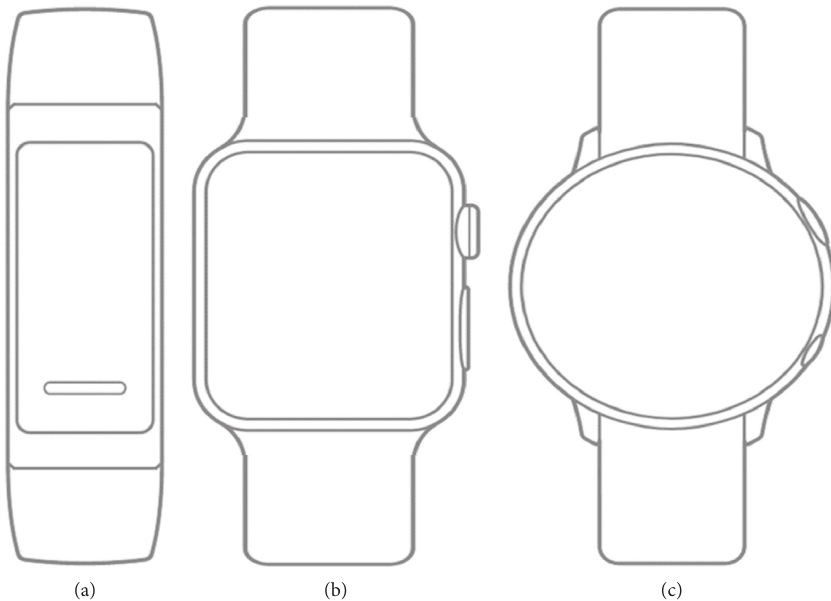
Figure 1: Smartwatch typical structures: (a) bracelet, (b) rectangular, and (c) round [13].